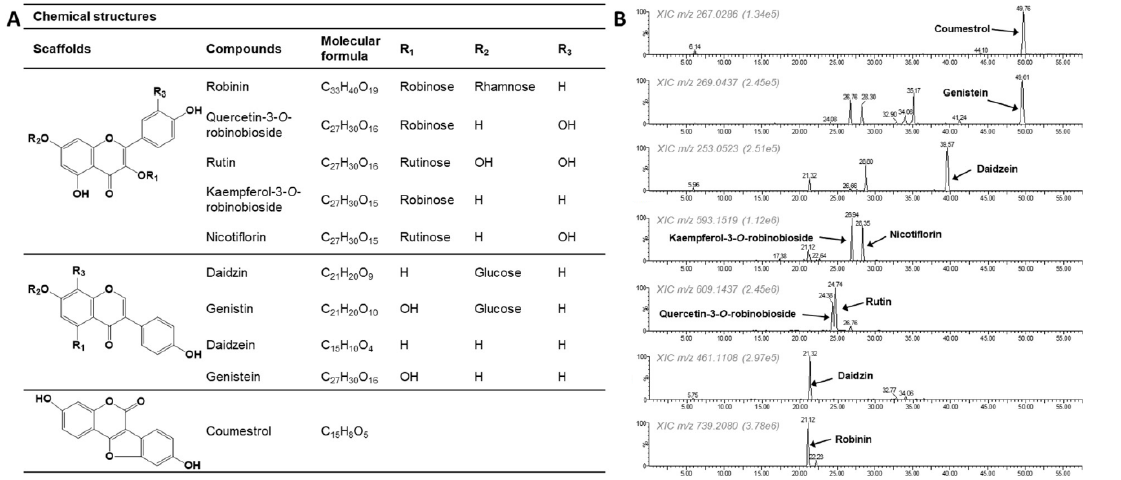
Figure 1. Chemical structures ( A ) and extracted ion chromatograms ( B ) of compounds present in PL-L-70E.